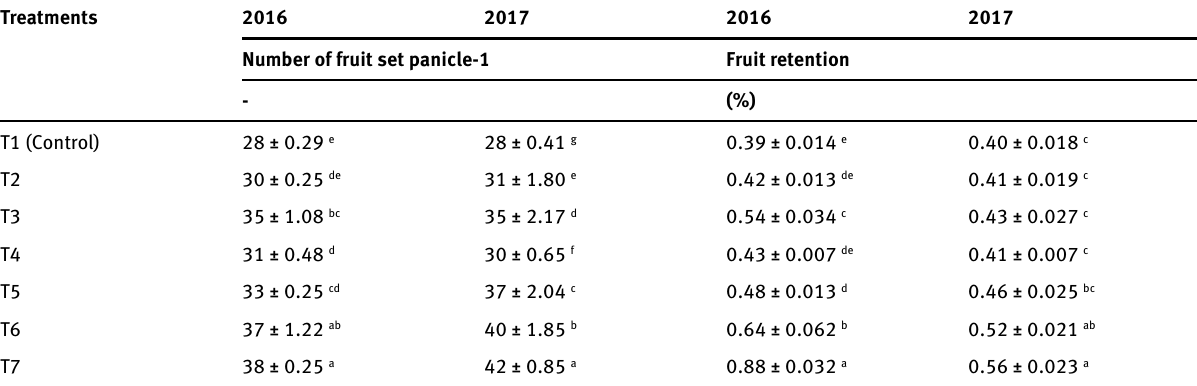
Table 2. Effects of foliar application of variable sources of Ca and K with Boric acid on number of fruit set panicle -1 and fruit retention of SB Chaunsa Treatments